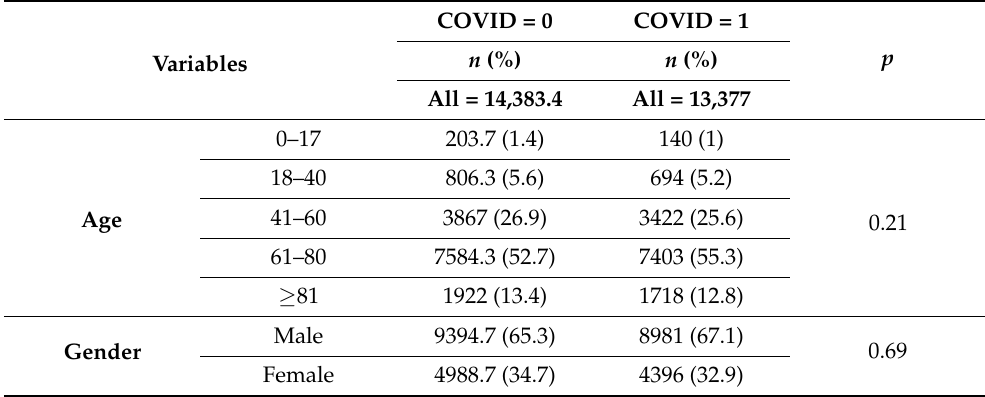
Table 1. Characteristics of patients enrolled in the analysis in 2017–2019 and 2020. COVID = Variables